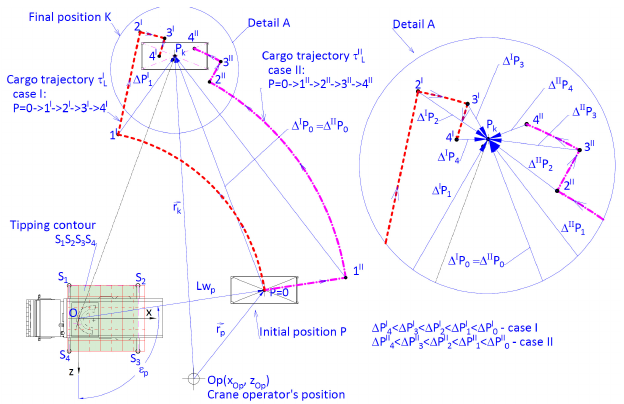
Figure 14. Diagram of the working cycle of the crane for assessing the accuracy of positioning the cargo in intermediate positions (1 I , 2 I , 3 I , 4 I , 5 I , 6 I —case I and 1 II , 2 II , 3 II , 4 II , 5 II , 6 II —case II) in relation to the final position depending on the crane operator’s position— Op for two cases of the cargo handling